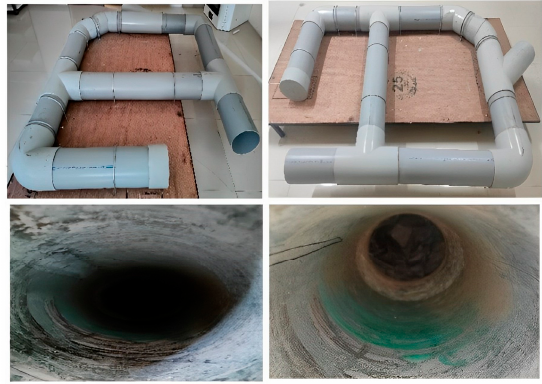
Figure 3. Constructed sewer pipeline.